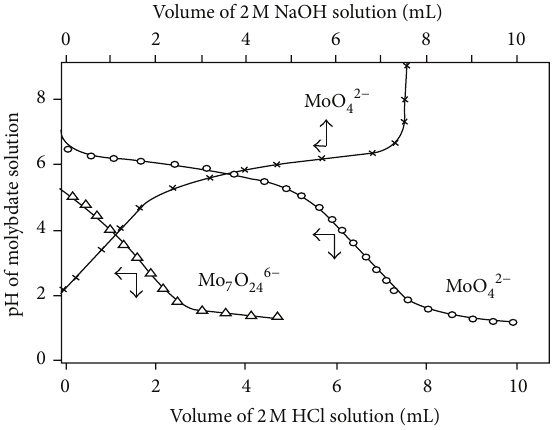
Figure 9: pH titration curves of molybdate gel sorbents [57, 59, 60,